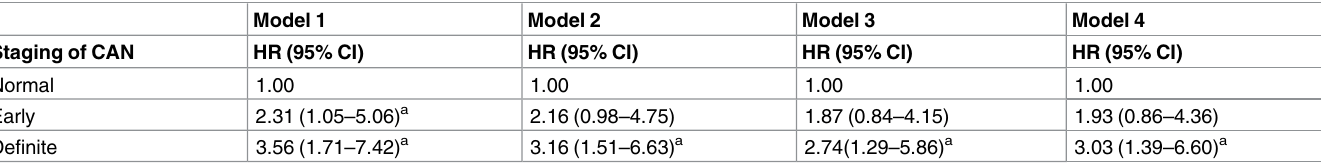
Table 3. Multivariable Cox hazards regression model for the risk of recurrent cardiovascular